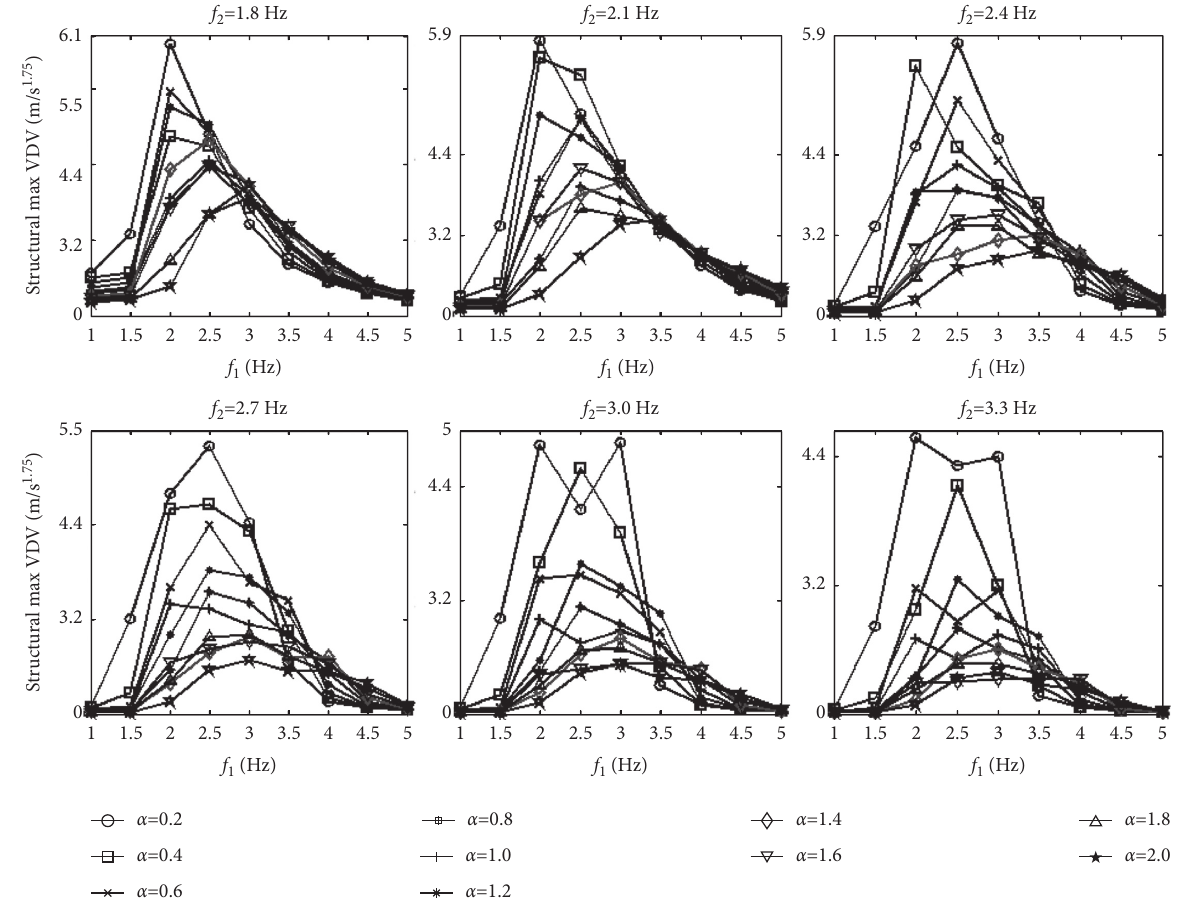
� 2.8Hz. 2 when f 3